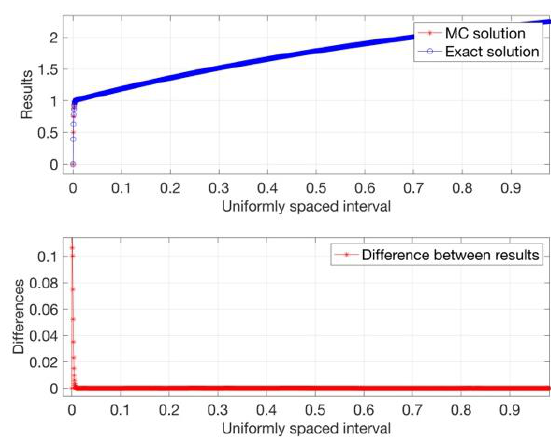
Figure 1. Comparison of the MC prediction and the exact solution of equation (3)